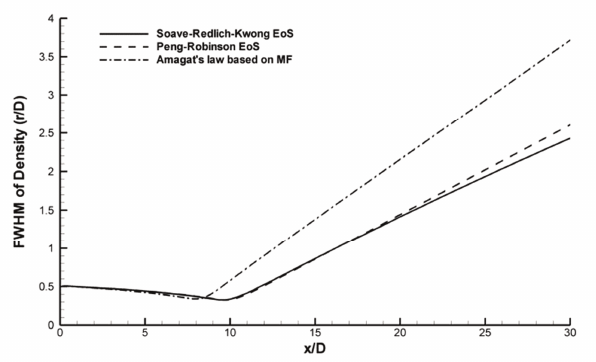
Fig. 9. Axial density distribution for supercritical case